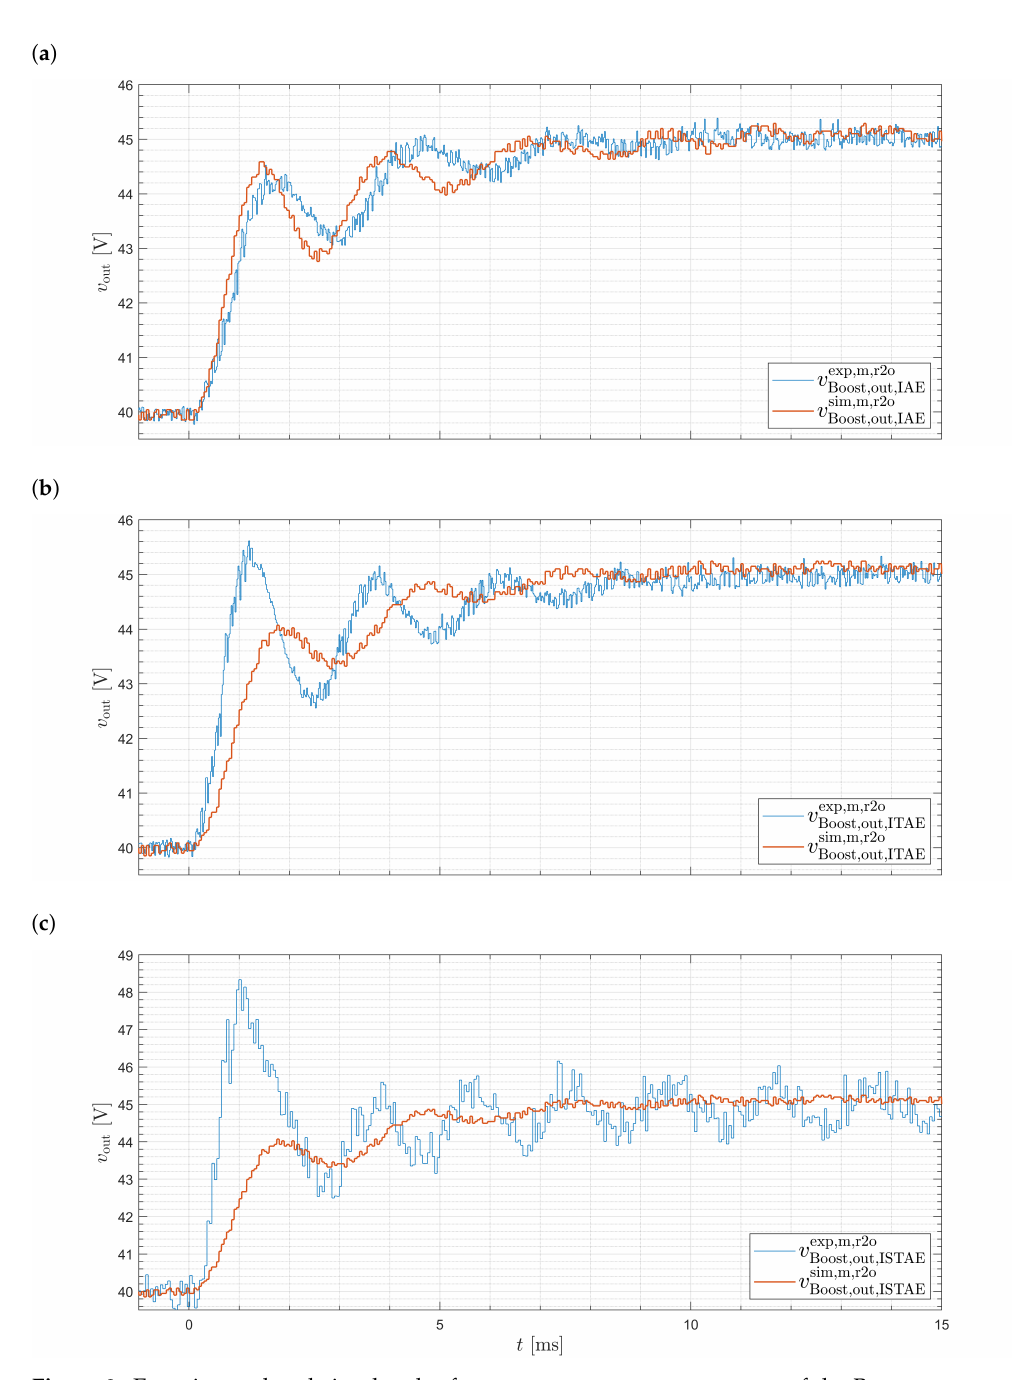
Figure 9. Experimental and simulated reference-to-output step responses of the Boost converter output voltage, v exp,m,r2o and v sim,m,r2o respectively, for different K P and K I compensator gains, Boost,out,. Boost,out,. see Table 2. The gains have been selected selected by means of unconstrained GA basing on three different fitness functions: ( a ) IAE according to Equation (26); ( b ) ITAE according to Equation (27); ( c ) ISTAE according to Equation